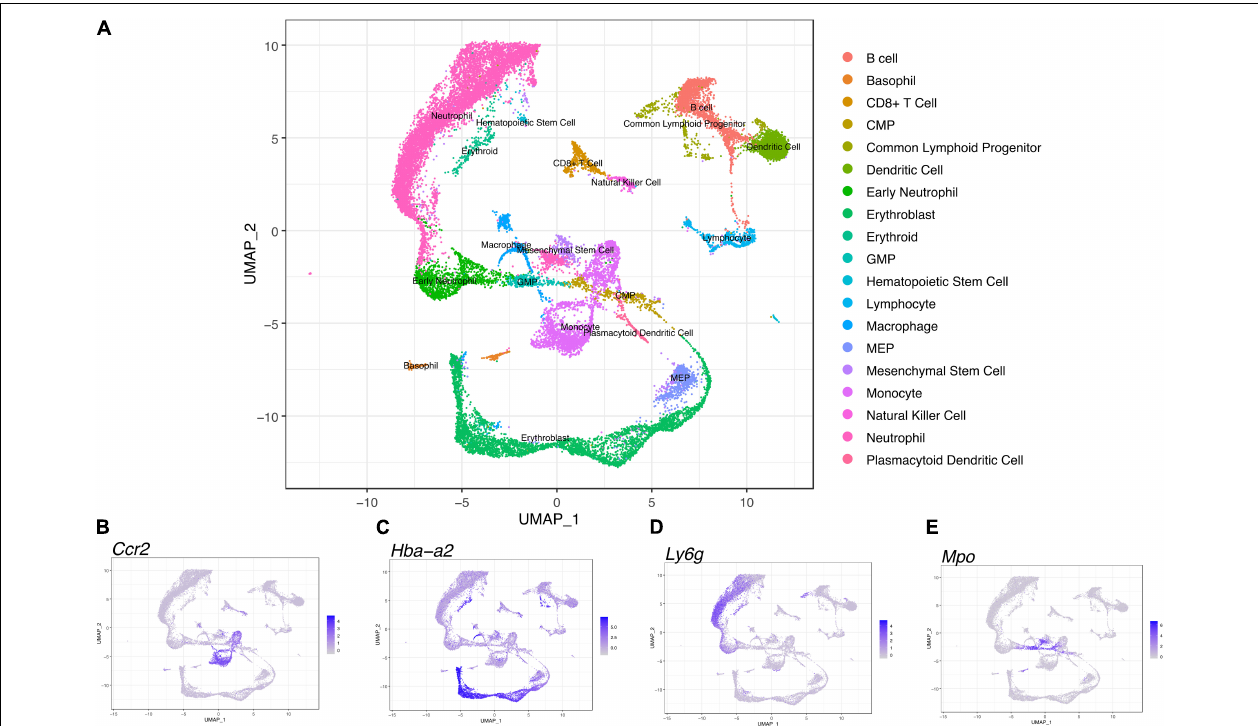
FIGURE 4 | Transcriptional profiling of bone marrow-derived cells reveals a differentiation landscape with 19 distinct cell subpopulations. (A) Integrated Seurat analysis of femur and mandible samples from total mouse bone marrow displayed in UMAP. Clusters were annotated based on known marker genes. Feature plots of (B) Ccr2 , (C) Hba-a2 , (D) of Ly6g , and (E) Mpo expression shown as representative markers of monocytes, erythroblasts, neutrophils, and myeloid progenitor populations,